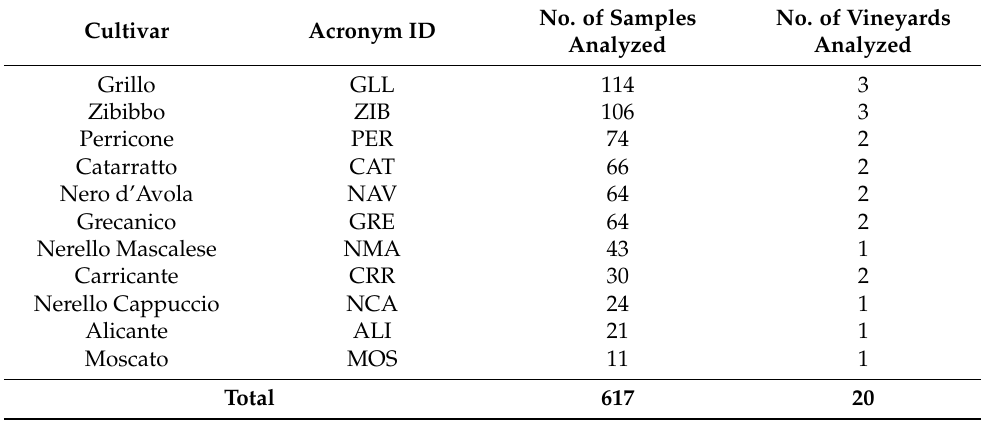
Table 1. List of grapevine cultivars analyzed by DAS-ELISA for GLRaV-1/GLRaV-3. No. of Samples No. of Vineyards Cultivar Acronym ID Analyzed Analyzed Grillo GLL 114 3 Zibibbo ZIB 106 3 Perricone PER 74 2 Catarratto CAT 66 Nero d’Avola NAV 64 Grecanico GRE Nerello Mascalese NMA Carricante CRR Nerello Cappuccio Alicante ALI Moscato MOS Total 617